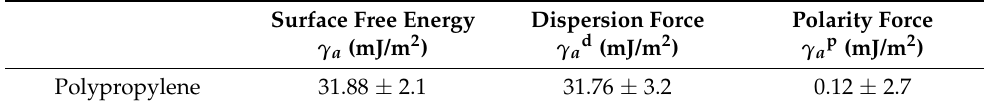
Table 3. Surface free energy components of polypropylene.